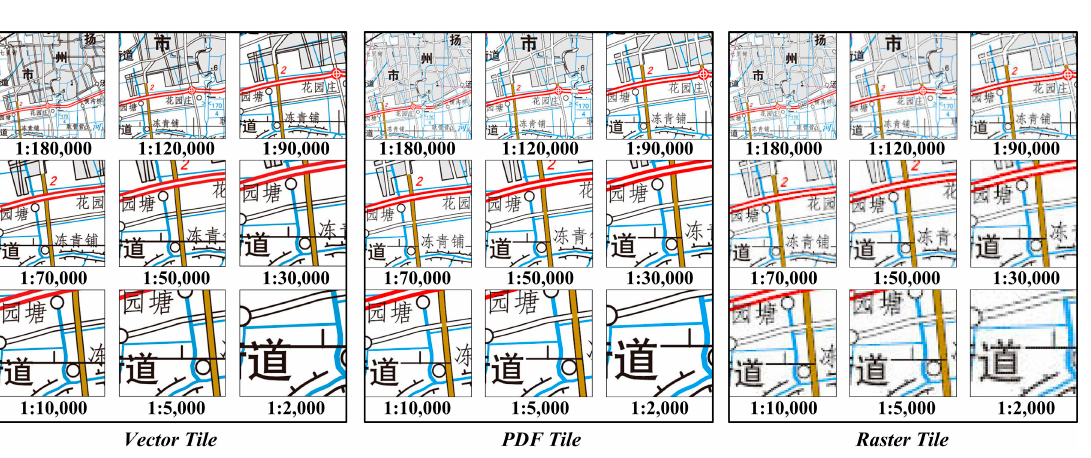
Figure 23. Visual effect of vector tiles, PDF tiles, and raster tiles at different zoom ratios. Figure 23. Visual e ff ect of vector tiles, PDF tiles, and raster tiles at di ff erent zoom